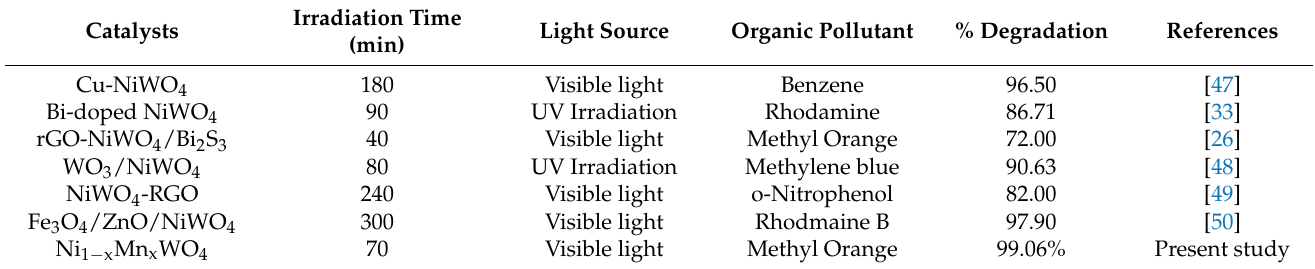
Table 2. Comparison of the literature information with the present